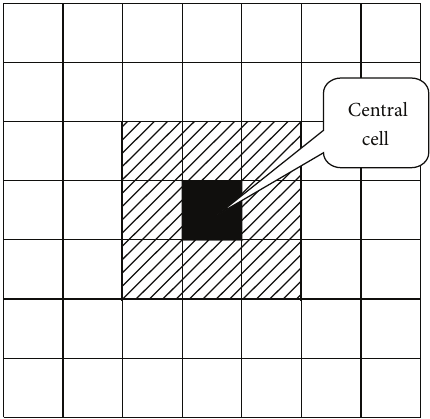
Figure 2: Schematic diagram of cellular, cellular space, and neigh-